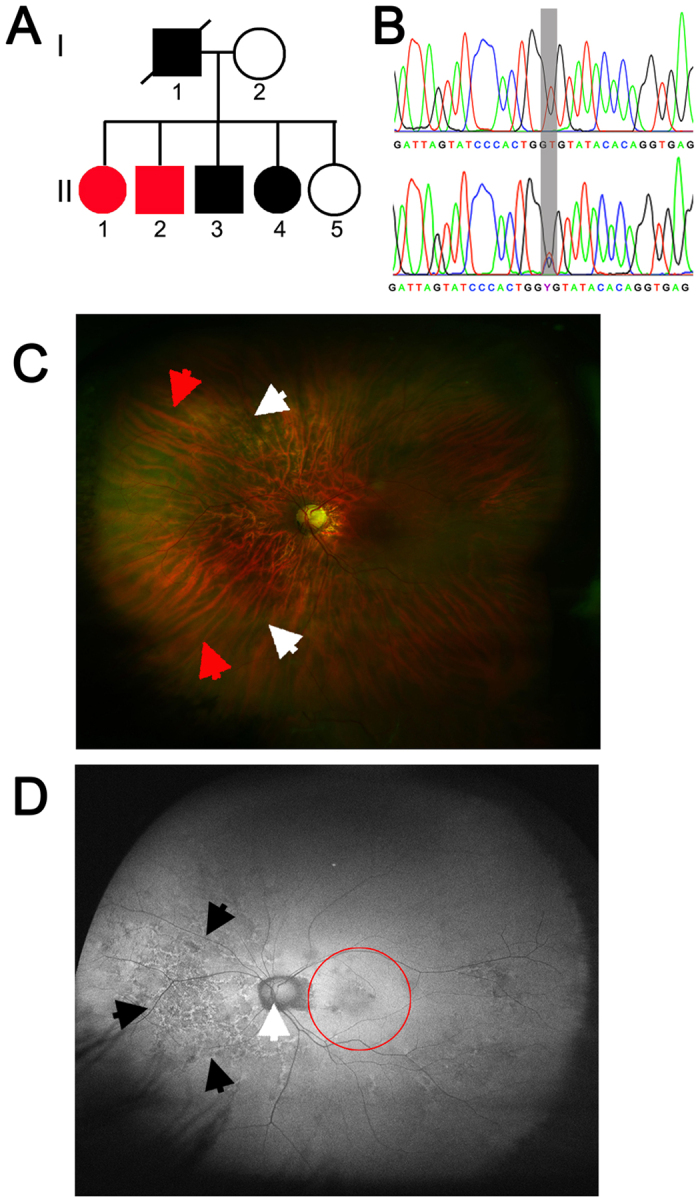
Clinical features of the ADVIRC patient Proband II-2.(A) Pedigree of the ADVIRC family investigated in this study. Probands II-1 and II-2, highlighted in red, were used as volunteers for this study. (B) Sanger sequencing of control (upper) and proband II-2 (lower) genomic DNA, the grey bar highlights the c.704T > C mutation within Exon 6 in this family. (C) Optos widefield colour fundus photograph of the left eye shows the tigroid appearance of the fundus, white arrows highlight the appearance of nasal temporal retinal atrophy, whilst red arrows highlight the circumferential band of pigmentation. The optic nerve is observed as the central yellow structure. (D) OPTOS widefield fundus autofluorescence images of the left eye of proband II-2. The black arrows highlight the nasal area of increased autofluorescence signifying RPE cell loss, the white arrow indicates the optic nerve and the red circle indicates the macula area (The subjects eyelashes are observed in the lower portion of the image).